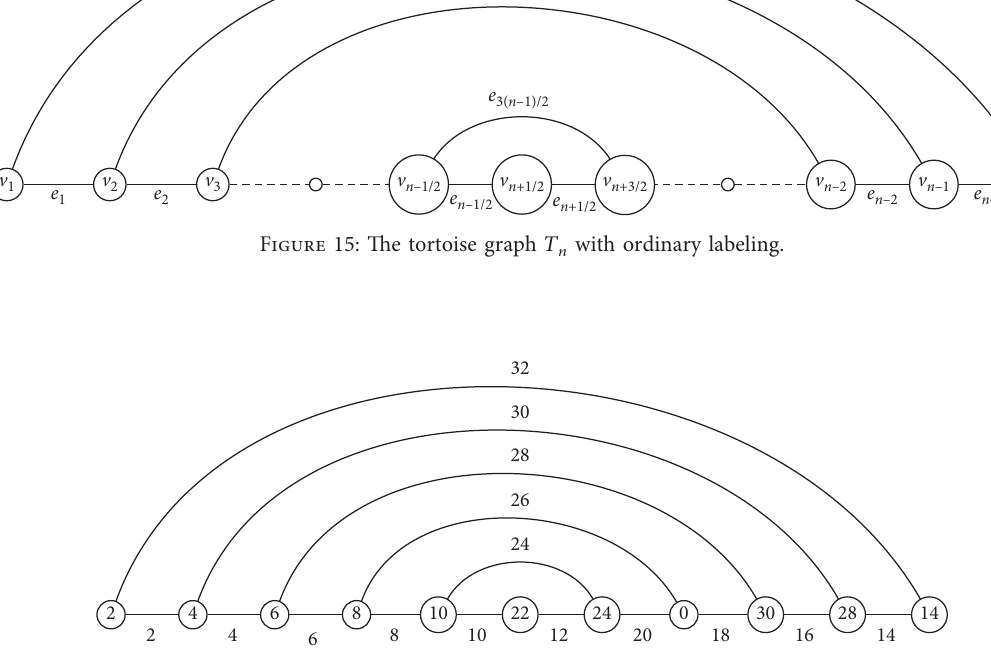
Figure 16: A 2-edge even graceful labeling for the tortoise graph T